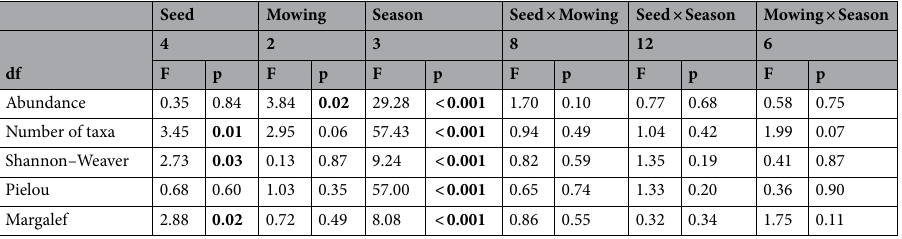
Table 2. The statistical summary of the effects of experimental treatments on the community indices of soil invertebrates. Bold values indicate significant